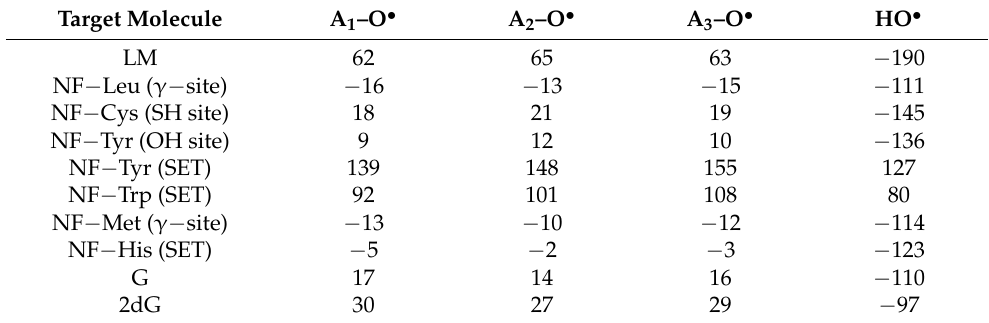
Table 3. Estimated values of reaction Gibbs energies ( ∆ r G ) in kJ · mol − 1 for reactions between